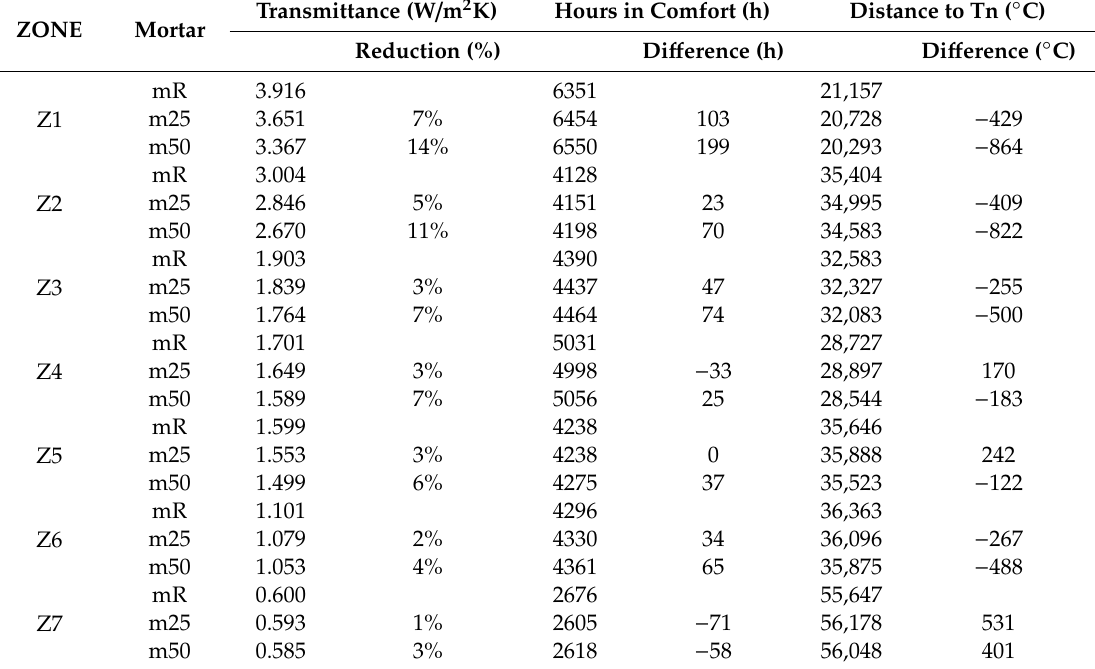
Table 7. Hours in thermal comfort and distance in respect to the neutral temperature by zones considering the mortar